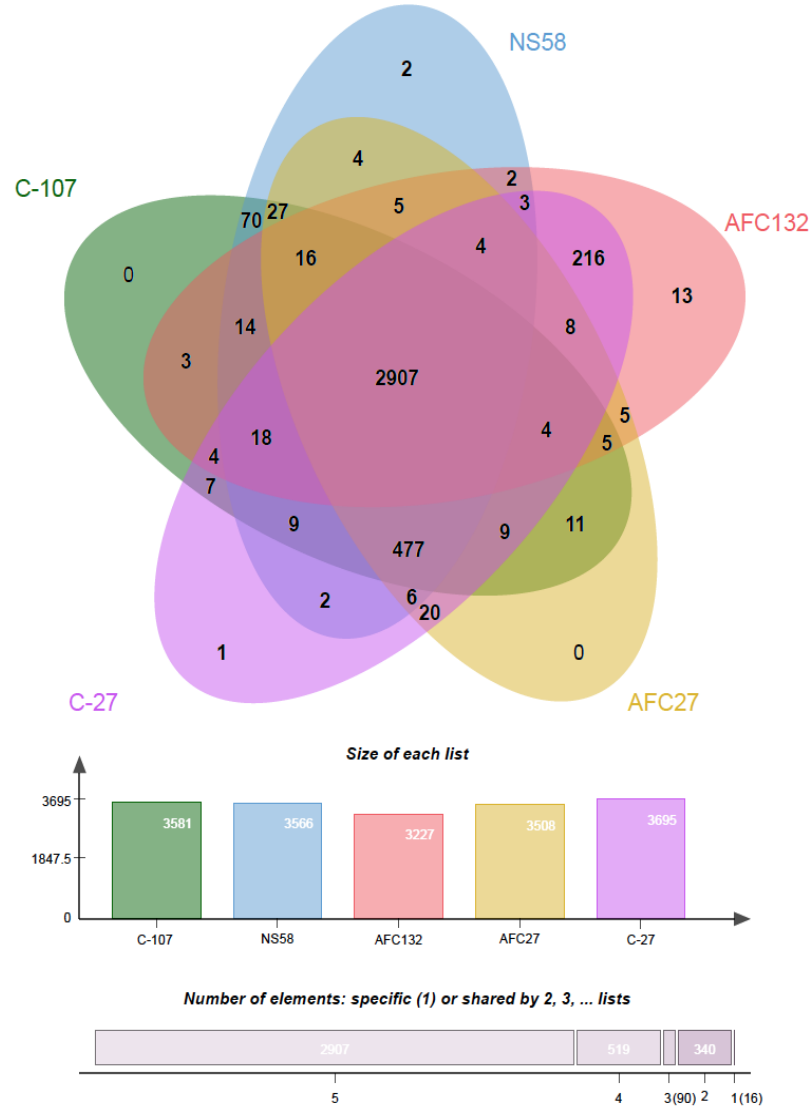
Figure 5. Venn diagram drawn using OrthoVenn2 [43] showing the genome comparison of five N. oceani strains. Pairwise sequence similarities between all input protein sequences were calculated with an e-value cut-o ff of 1e − 5. An inflation value ( I ) of 1.5 was used to define orthologous cluster structure. The core genome of the N. oceani species consists of 2907 CDS. The species forms 3872 CDS clusters, 980 orthologous clusters (containing ≥ 2 species), and 2892 single-copy gene clusters.